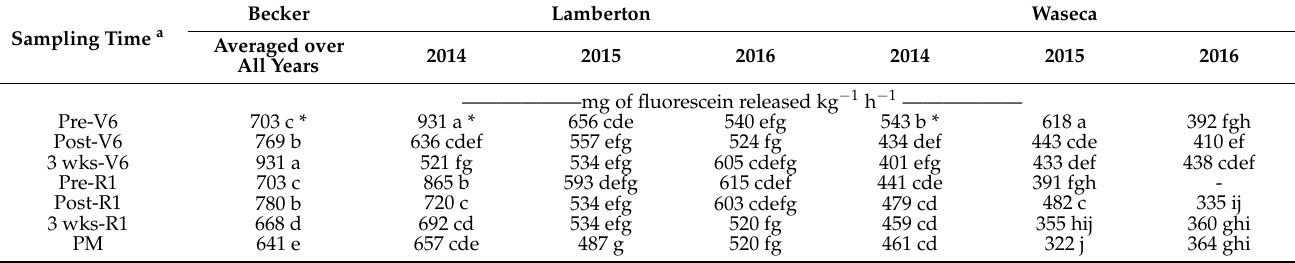
Table 3. In-season fluorescein diacetate (FDA) hydrolysis at Becker, Lamberton, and Waseca. Becker Lamberton Waseca Sampling Time a Averaged over All